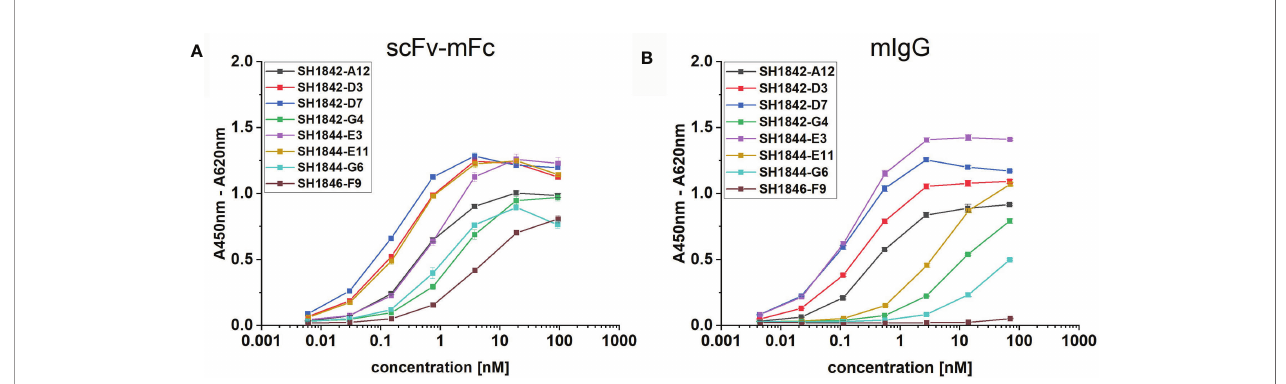
FIGURE 4 | Comparison of scFv-Fc or IgG format in ELISA binding assay. Eight mAbs were produced respectively as (A) scFv-mFc (mIgG2a-Fc) or (B) full mIgG2a. 500 pg/mL to 10 µg/mL were incubated against 100 ng immobilized hFc antigen, representing molar concentrations spanning from (A) 5.95 – 6.08 pM to 92.92